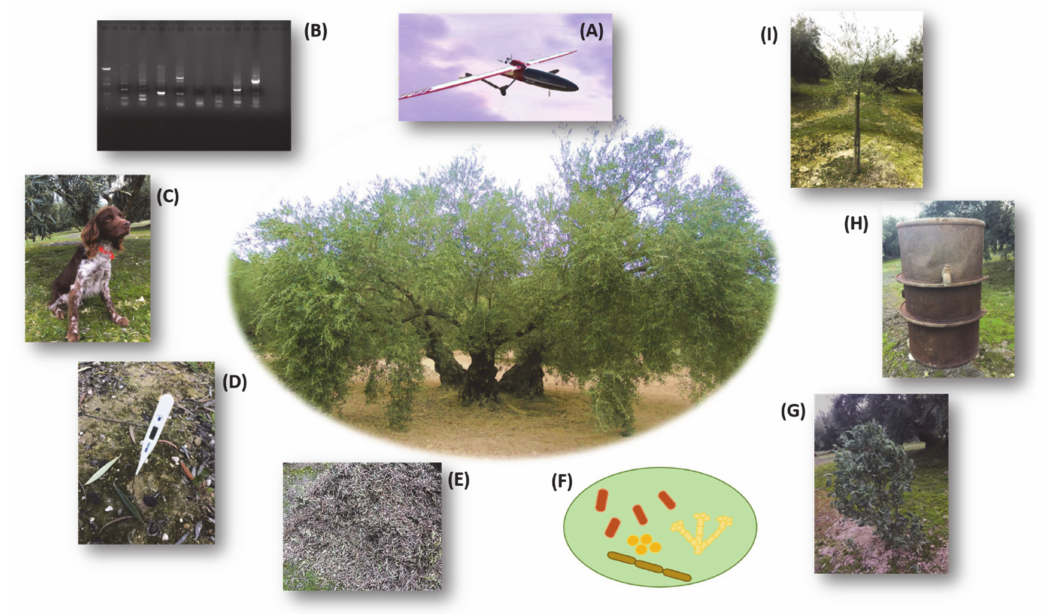
Figure 5. An idealized compilation of the available Verticillium wilt of olive control measures described in this review to be implemented within an integrated management strategy. ( A ) Use of spectral technologies coupled with drones or UAV for the early detection of the disease at a large scale (modified form an image kindly provided by Dr. J.A Jim é nez Berni, IAS-CSIC, C ó rdoba); ( B ) identification based on molecular methods; ( C ) dogs trained for the detection of Verticillium dahliae volatile compounds; ( D ) heat treatments; ( E ) organic amendments; ( F ) biological control agents; ( G ) the use of plant